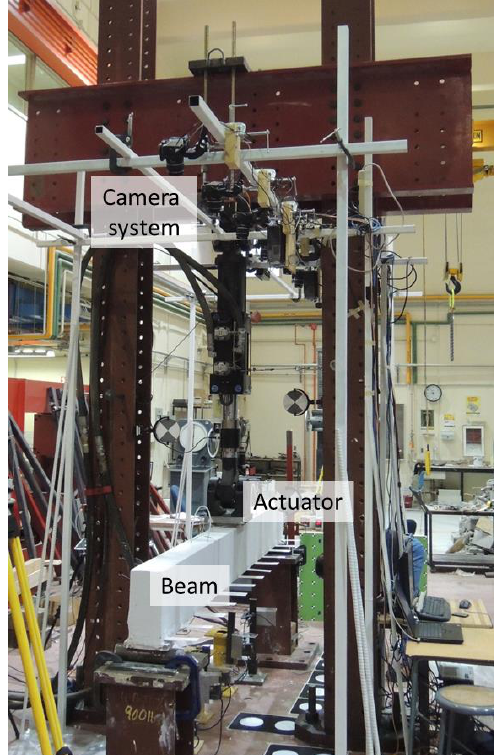
Figure 7. Experiment setup showing the hydraulic actuator and the concrete beam